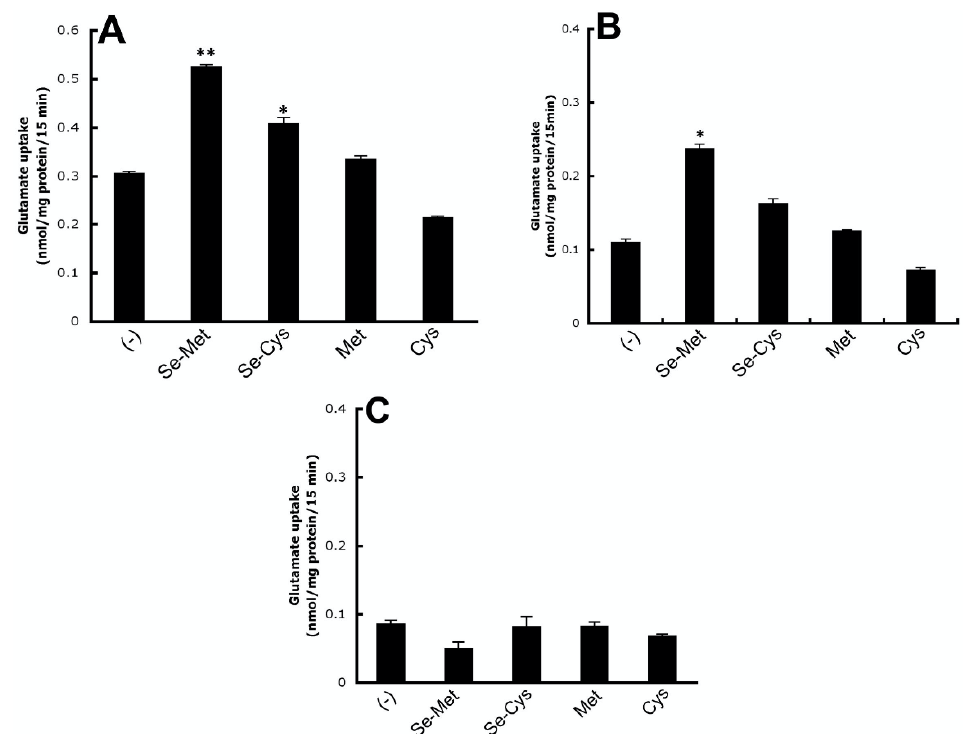
Figure 5. Differential influence of selenoamino acids (Se-Met and Se-Cys) and sulfur amino acids (Met and Cys) on system xc- transport activity: ARPE-19 cells were cultured in the presence or absence of selenomethionine (Se-Met), selenocysteine (Se-Cys), methionine (Met), and cysteine (Cys), each at 1 mM, for 16 h. Uptake of [3H]-glutamate (2.5 μM) was measured for 15 min at 37 °C in the presence and absence of Na+: ( A ) Na+-independent, xc- -specific glutamate uptake; ( B ) total glutamate uptake; and ( C ) Na+ -dependent, excitatory amino acid transporter (EAAT)-specific glutamate uptake. (* p < 0.05, ** p < 0.01 compared to control).